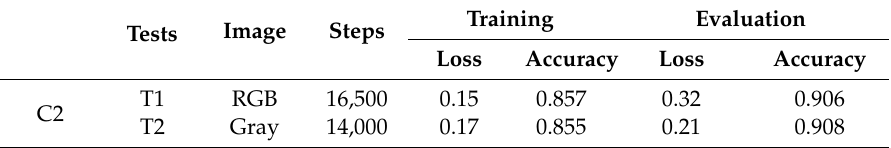
Table 5. Results obtained with the configuration C2—Using the complete